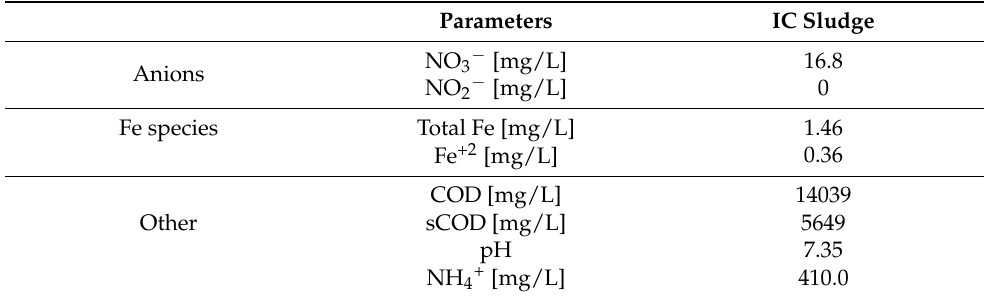
Table 1. Characterization of the IC anaerobic